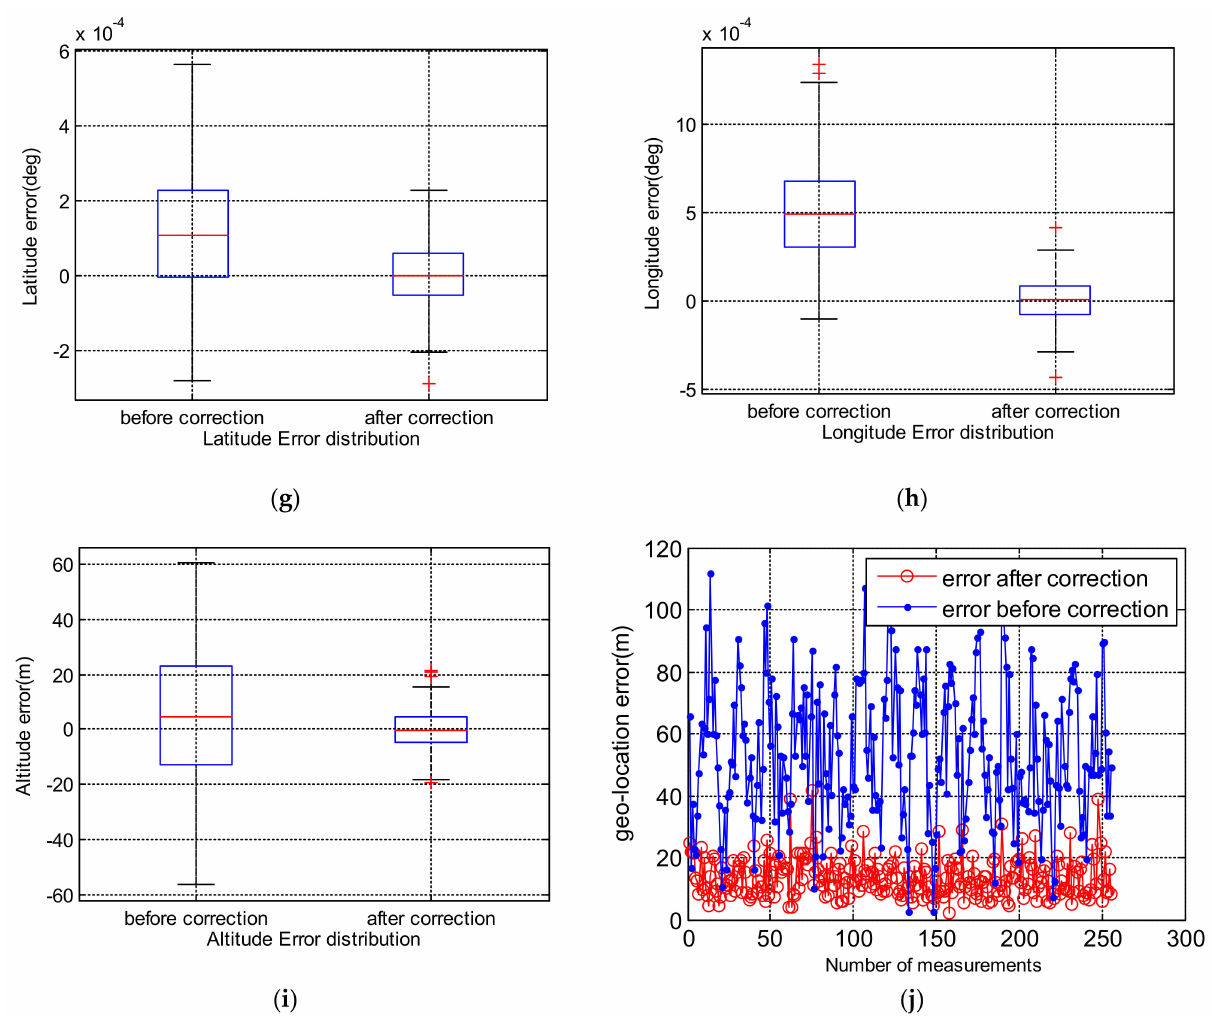
Figure 8. Simulation result of geo-location before and after correction: ( a ) Latitude error of geo-location before correction; ( b ) Latitude error of geo-location after correction; ( c ) Longitude error of geo-location before correction; ( d ) Longitude error of geo-location after correction; ( e ) Altitude error of geo-location before correction; ( f ) Altitude error of geo-location after correction; ( g ) Box plot of latitude error of geo-location before and after correction; ( h ) Box plot of longitude error of geo-location before and after correction; ( i ) Box plot of altitude error of geo-location before and after correction; ( j ) Error of geo-location before and after correction. Table 2. The comparison of geo-location between before and after